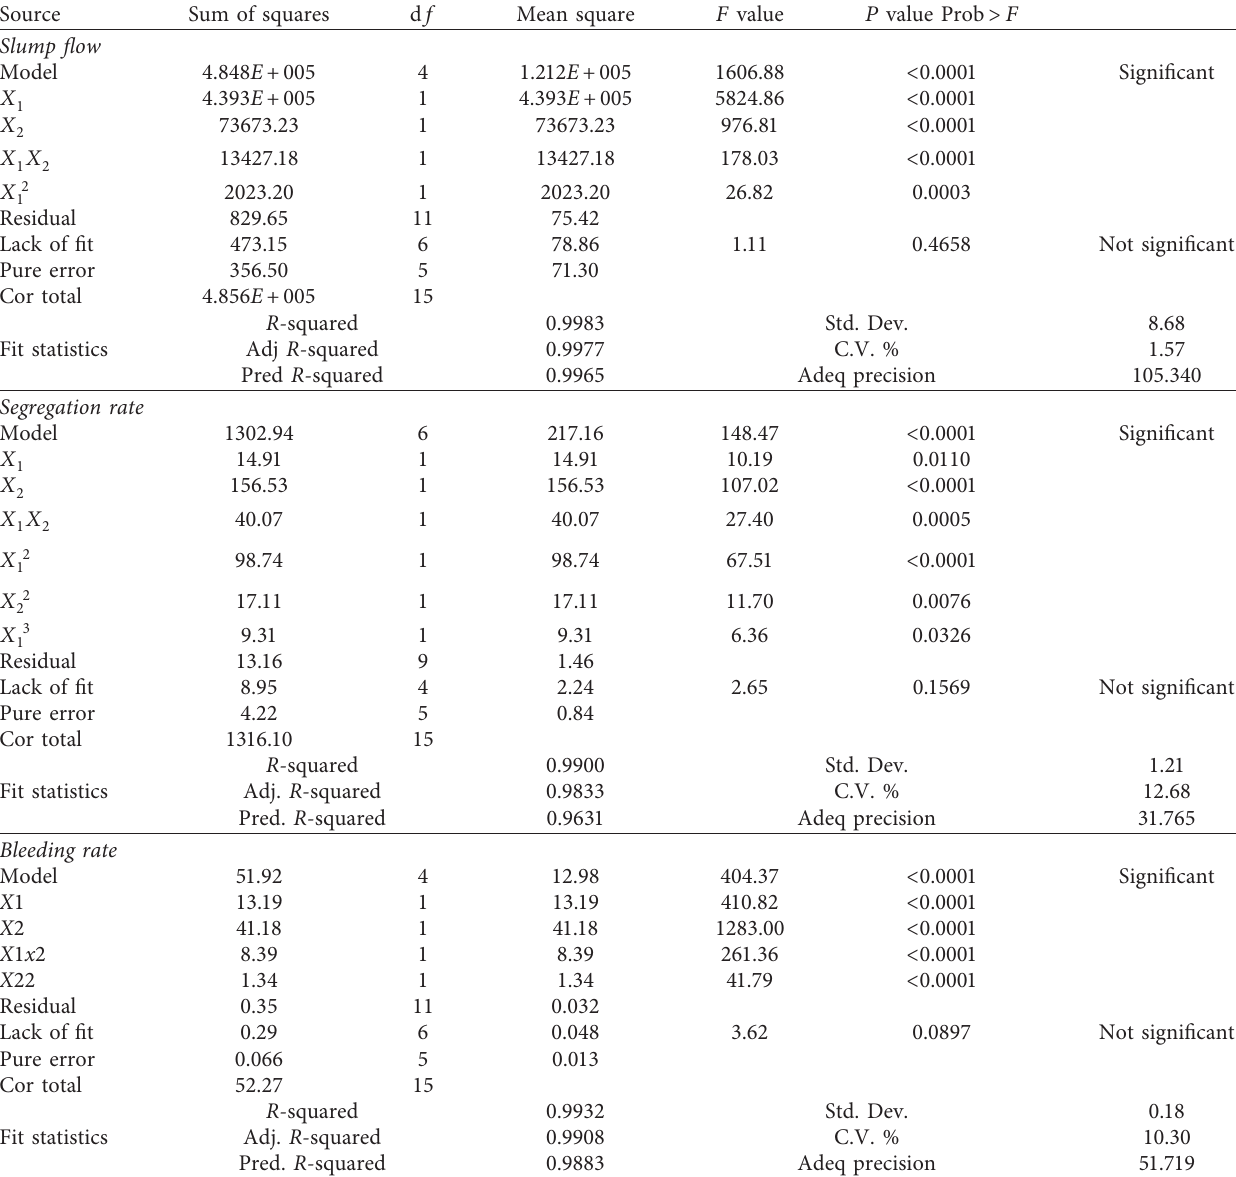
Table 6: The results of